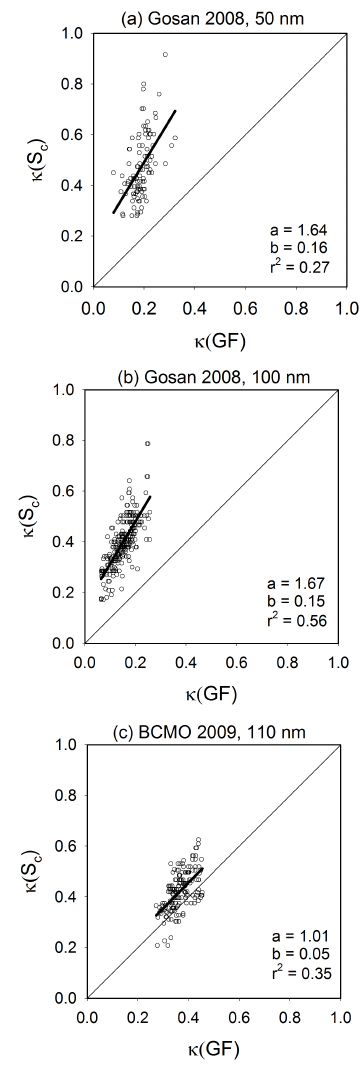
Fig. 9. Comparison of the estimated κ values from GF and S c measurements for 50 and 100nm D dry during Gosan 2008 and for 110nm D dry during BCMO 2009. The linear regression line ( y = ax + b , thick solid line) and the coefficient of determination ( r 2 ) are also